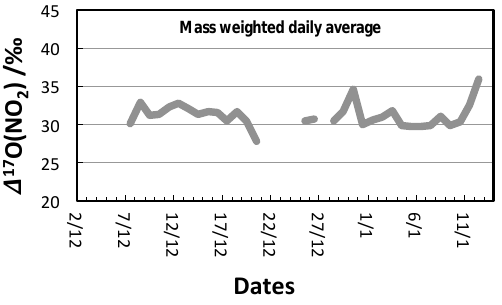
Figure 5. Quantitative assessment of the daily averaged trend in the (cid:49) 17 O of NO 2 at Dome C during December 2011– January 2012 derived from concurrent measurements of ozone, NO, and HO 2 / RO 2